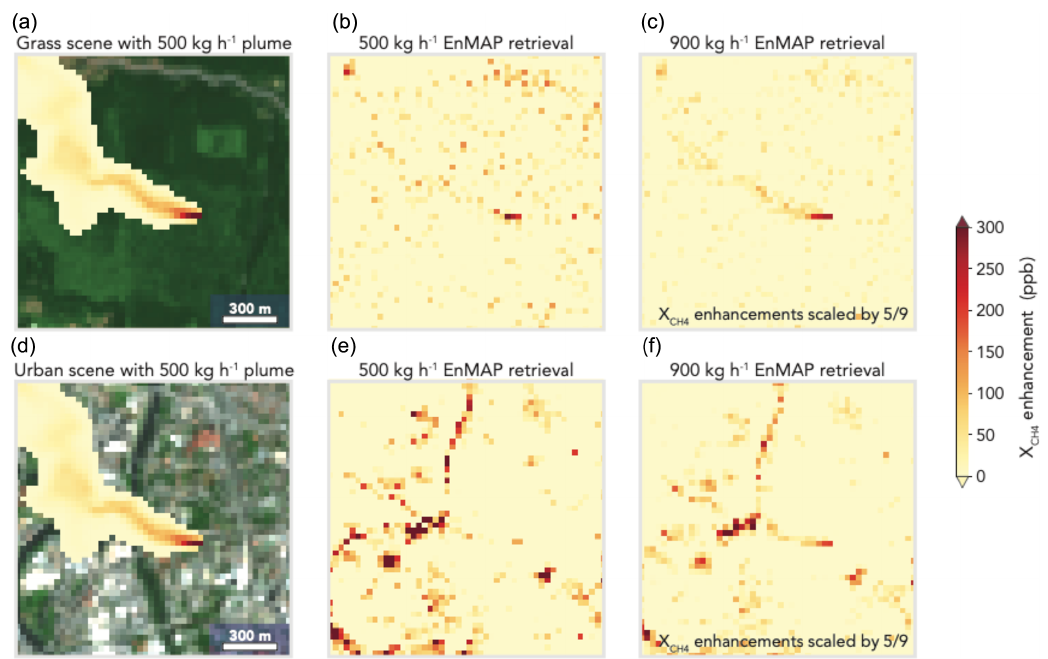
Figure 3. Retrieval of a methane plume over grass (a, b, c) and urban (d, e, f) EnMAP scenes. The plume was generated by WRF-LES at 30m × 30m resolution with a source rate of either 500kgh − 1 or 900kgh − 1 . The left panels show the dry air column mixing ratio ( X CH ) 4 enhancements relative to the 1800ppb background for a 500kgh − 1 methane plume superimposed on the RGB images of Fig. 2. The middle panels show the retrieval of those enhancements using the IMAP-DOAS retrieval algorithm applied to the EnMAP instrument specifications. The right panels show the retrieval of the 900kgh − 1 plume. The X CH enhancements in the right panels are scaled by 5 / 9 to be comparable 4 with the other panels. Negative enhancements are reset to equal the